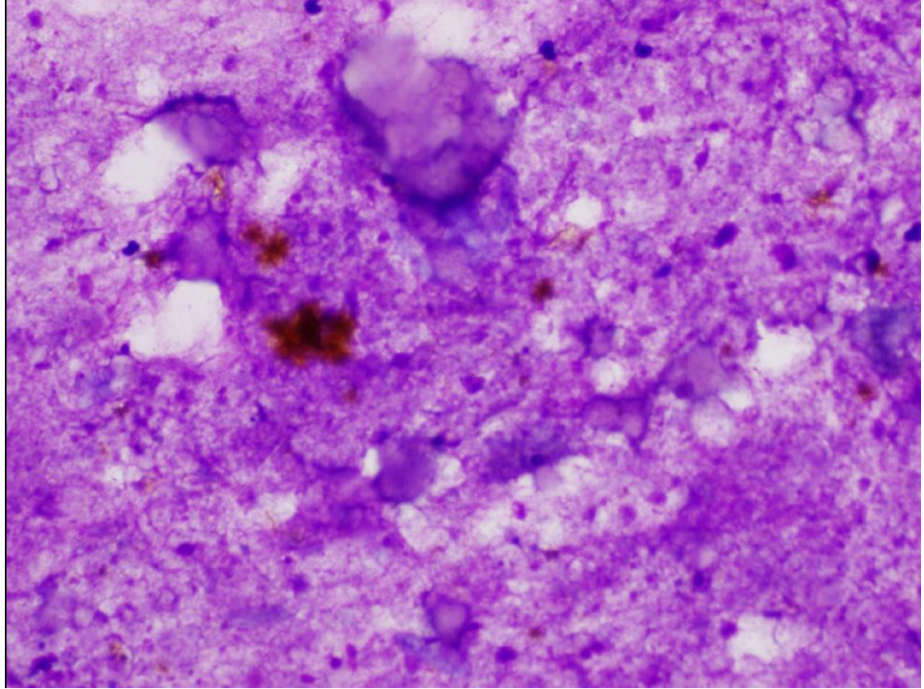
Figure 2. Smear specimen obtained from a pseudocyst. Smear is characterized by a dirty background, scattered chronic inflammatory cells and aggregates of golden-brown pigment. Epithelial cells are absent (Diff–Quik